Question: In a single sentence, describe what this figure presents.
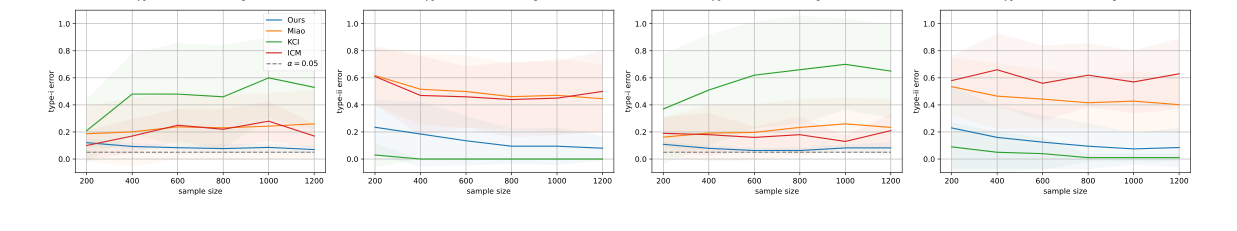
Answer: Type I and type II error rates of our testing procedure and baseline methods. Note that for a valid testing procedure, the type I error should be close to the significant level α (the dashed line), and the type II error should be close to zero.